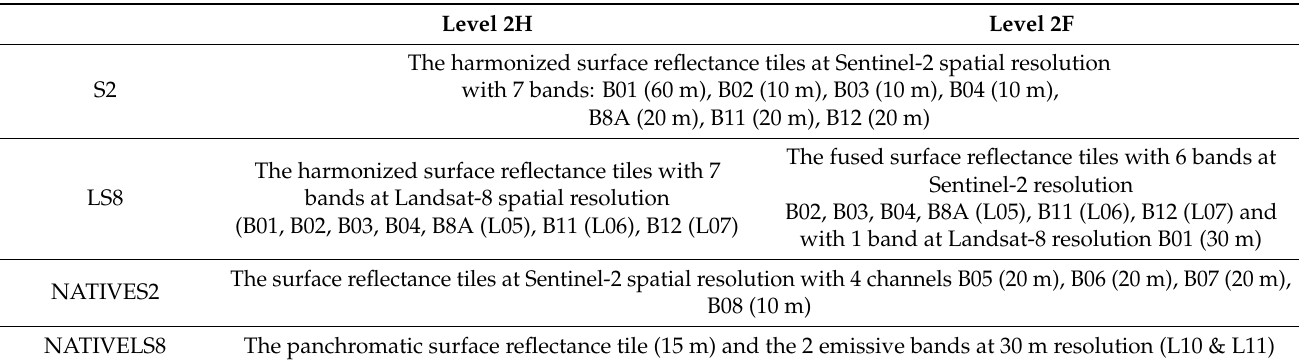
Table A1. Content of the Sen2Like Image Data folder (when required, the corresponding LS8 equivalent band is labeled with “L” as prefix instead of “B”).